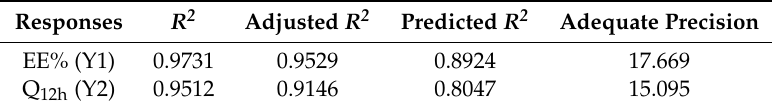
Table 2. Output data of the 2 3 factorial design of SV-loaded